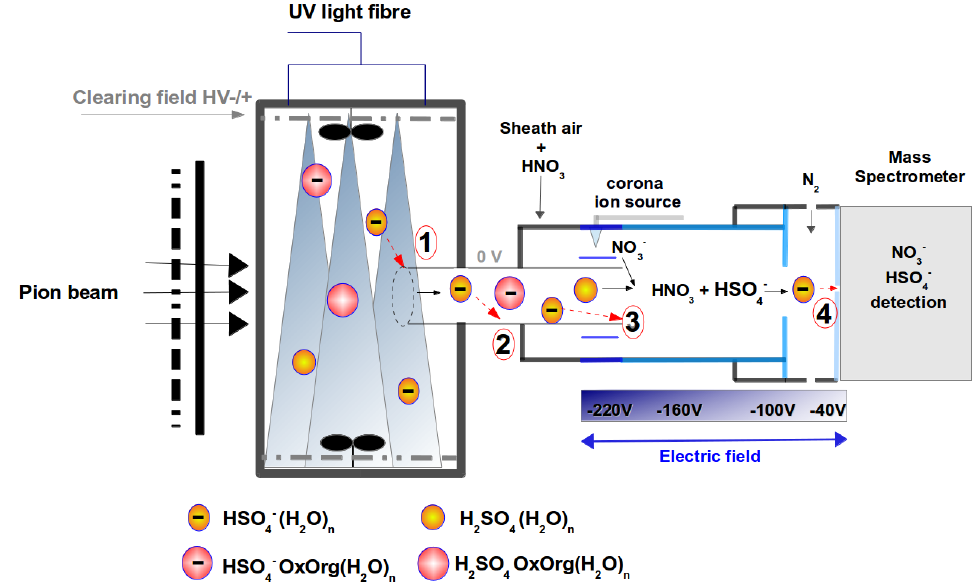
Figure 6. Schematic of the CLOUD chamber and the connected CIMS mass spectrometer. In a typical ion-induced binary (i.e. H 2 SO 4 + H 2 O) experiment (HV is switched off and the pion beam is on), not only H 2 SO 4 neutral molecules but also HSO − usually attached to water molecules (yellow), while for pinanediol runs the HSO − (magenta). During binary experiments, the produced bisulfate ions are presumably efficiently lost before reaching the mass spectrometer. Losses can occur due to diffusion and/or electrostatic forces: (1) at the entrance of the sampling probe, (2) within the sampling line, (3) during the transfer into the CIMS ion drift region and (4) before entering the mass